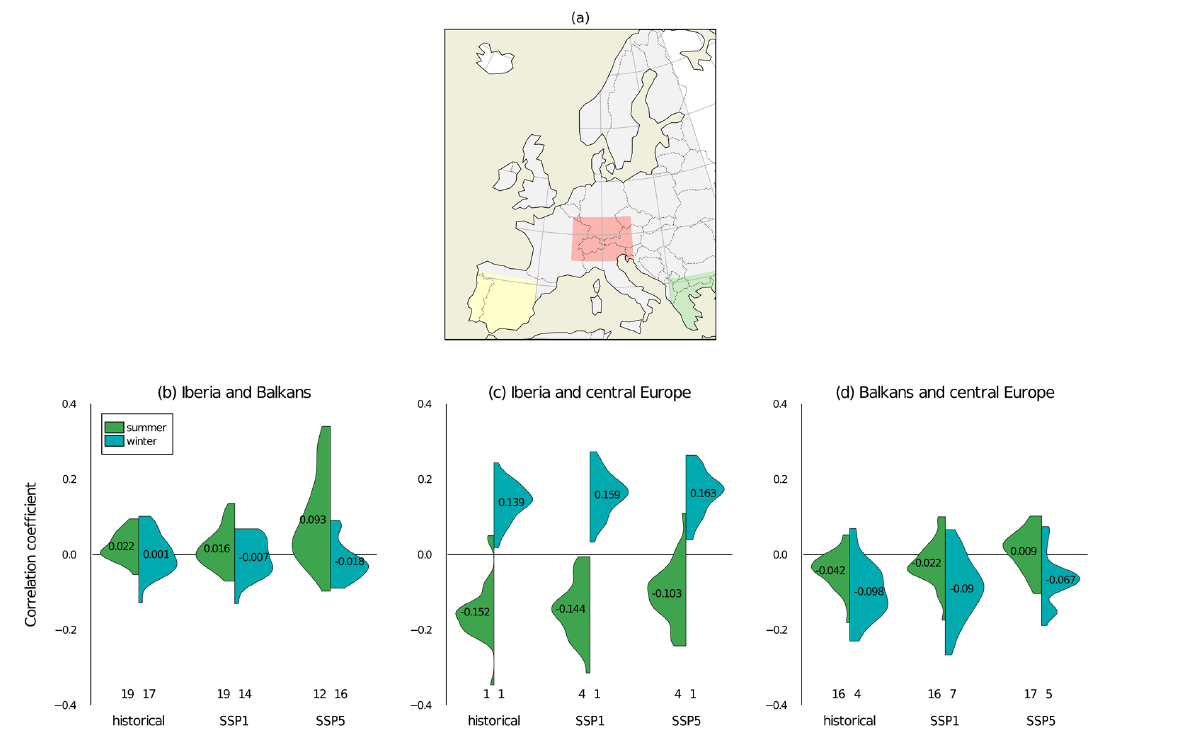
Figure 6. (a) Selected regions for the case study: Iberia (35–42.5 ◦ N, 10–0 ◦ W; yellow), the Balkans (35–42.5 ◦ N, 20 ◦ W–30 ◦ E; green), and central Europe (45–50 ◦ N, 5–15 ◦ E; red). The lower panels show the correlation of deseasonalized PV electricity production (b) between Iberia and the Balkans, (c) between Iberia and central Europe, and (d) between the Balkans and central Europe for the historical and the two SSP scenarios based on daily data. The green and blue colors distinguish correlations in summer and winter, respectively. The violin shapes represent the probability density function of the 28 models used. The numbers in the middle indicate the mean correlation coefficient for the specific scenario in each season. The values below each violin part show the number of models (out of 28) for which the null hypothesis (zero correlation) cannot be rejected at the 5% level. At the same time, the rest of the models have a statistically significant nonzero